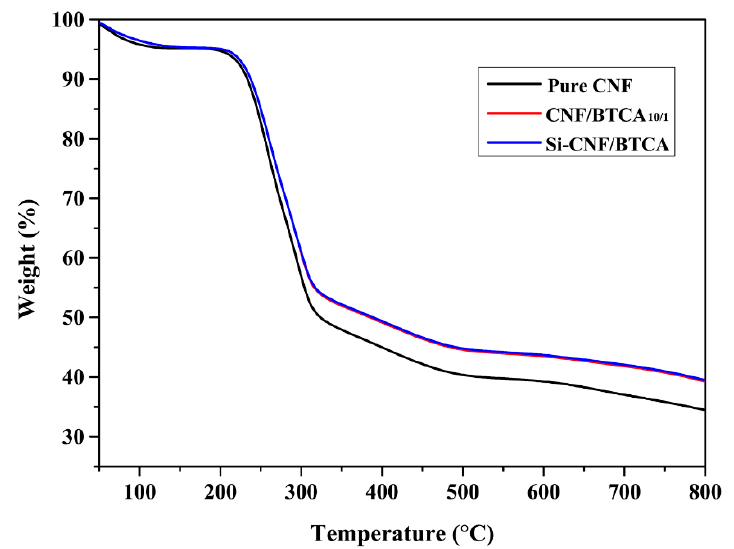
Figure 4. Thermogravimetric analyses (TGA) curves of the pure CNF, CNF/BTCA 10/1 , and Si-CNF/BTCA